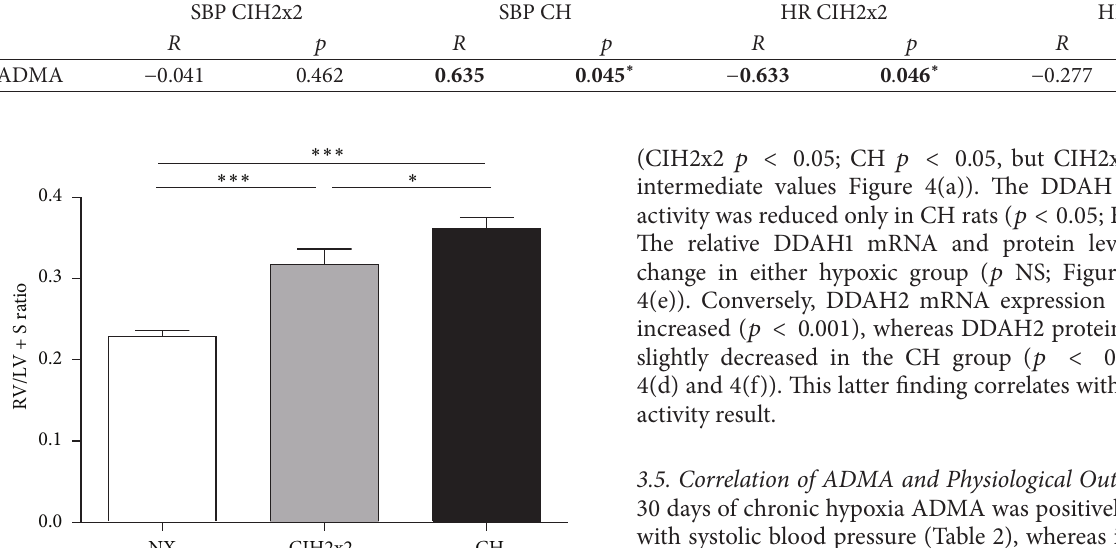
172.4 ± 5.6 mmHg) groups. Significant changes in the heart rate were not detected in any of the